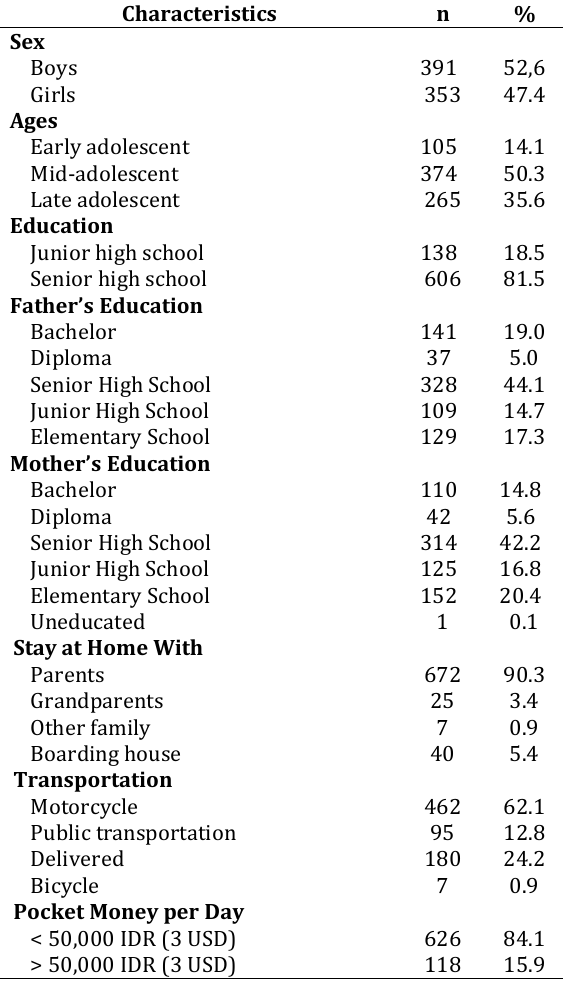
Table 2. Correlation between Premarital Sexual